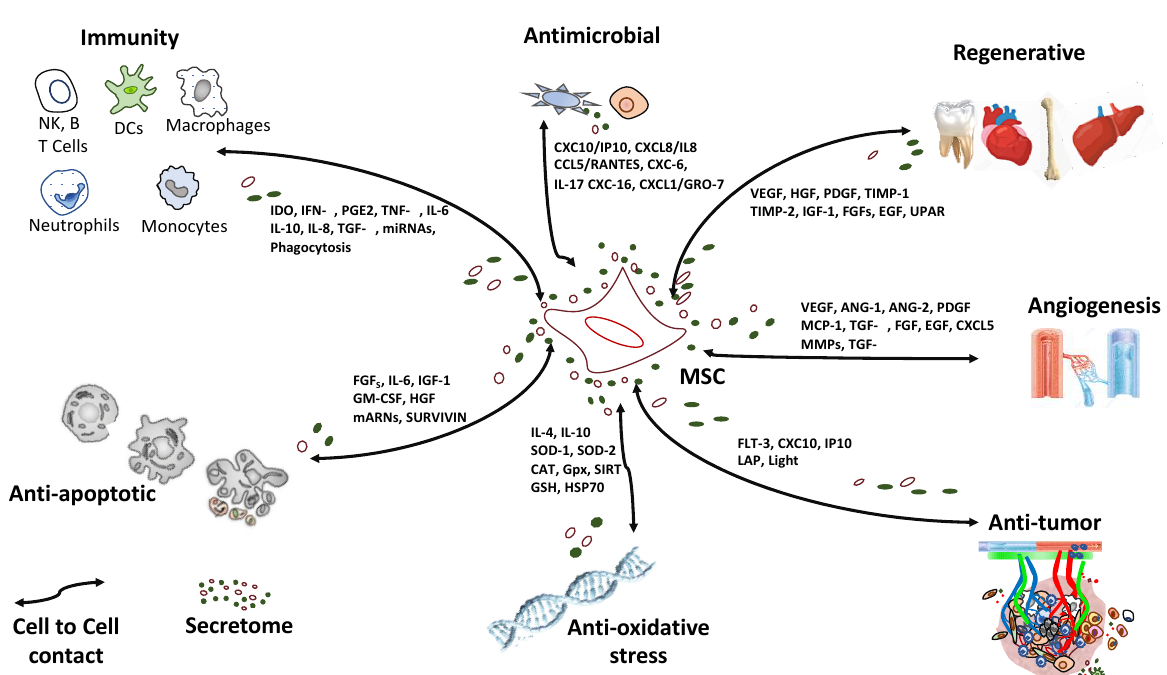
Figure 1. Mesenchymal stem cells (MSC) in the context of a “galaxy” of intercellular signals. Mesenchymal stem cells participate in different physiological processes through secreted factors (secretome) or by cell-to-cell contact.